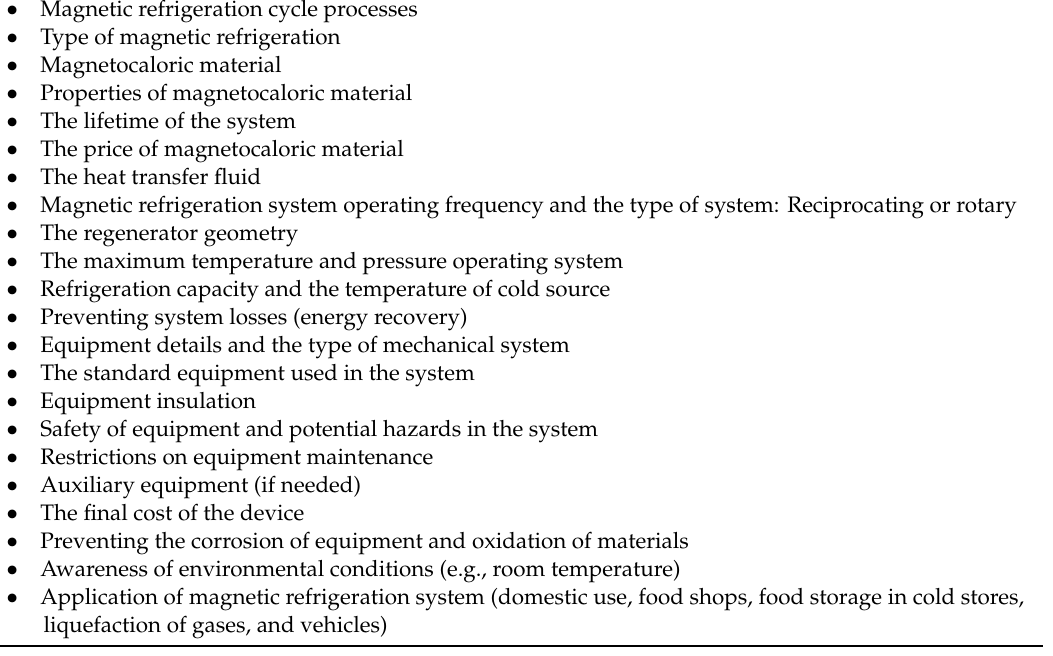
Table 5. Parameters required for the design of a magnetic refrigeration